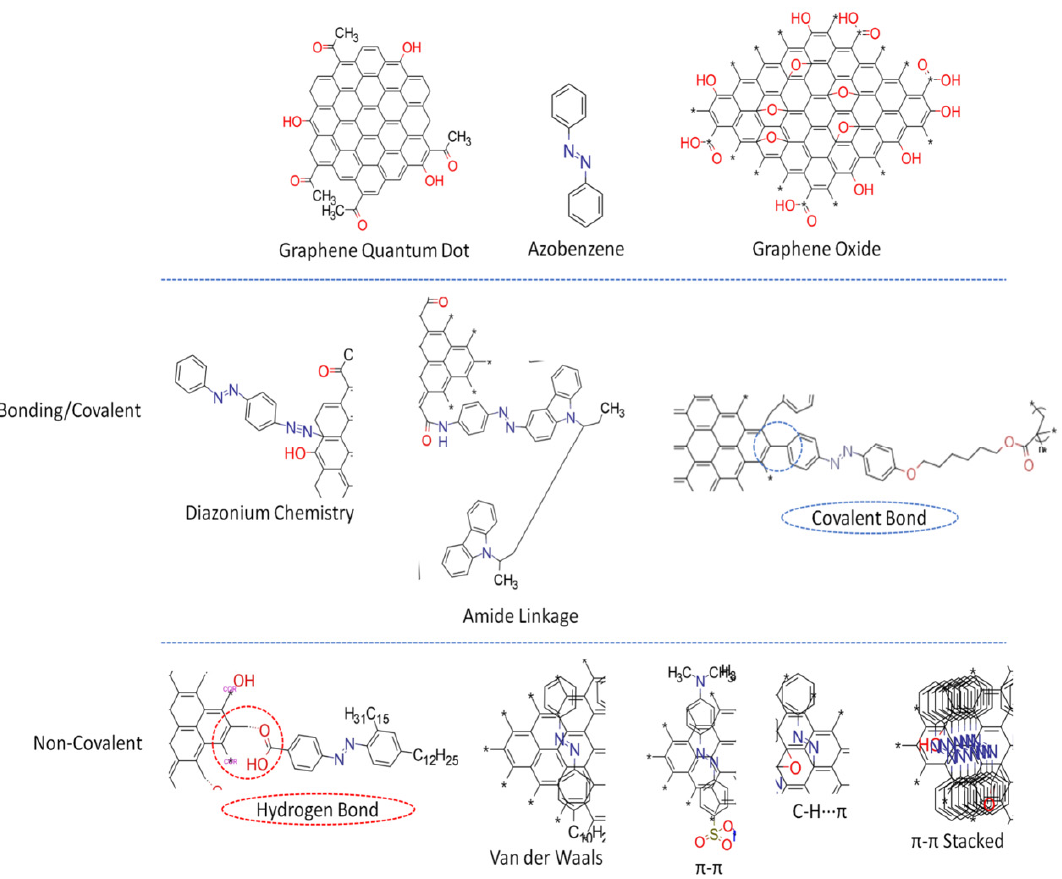
Figure 10. Synthesis strategies for GD-AZO composites [87].